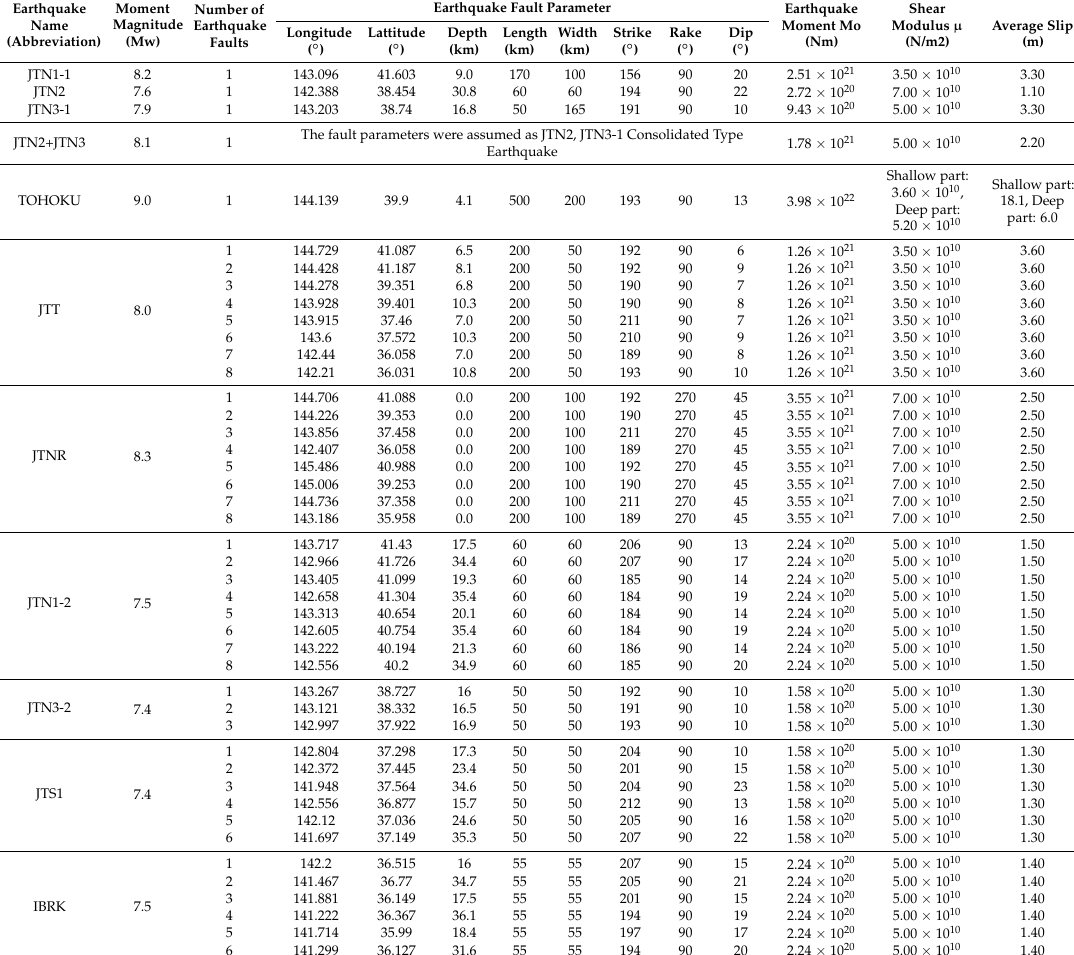
Table 4. Fault parameters for the reference magnitude of each assumed fault.